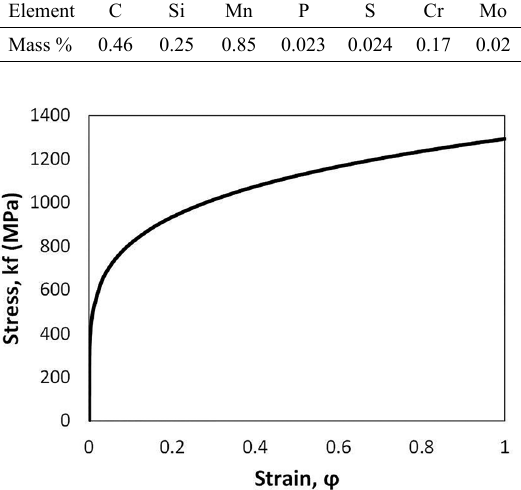
Figure 1. Flow curve of the SAE 1045 7 .